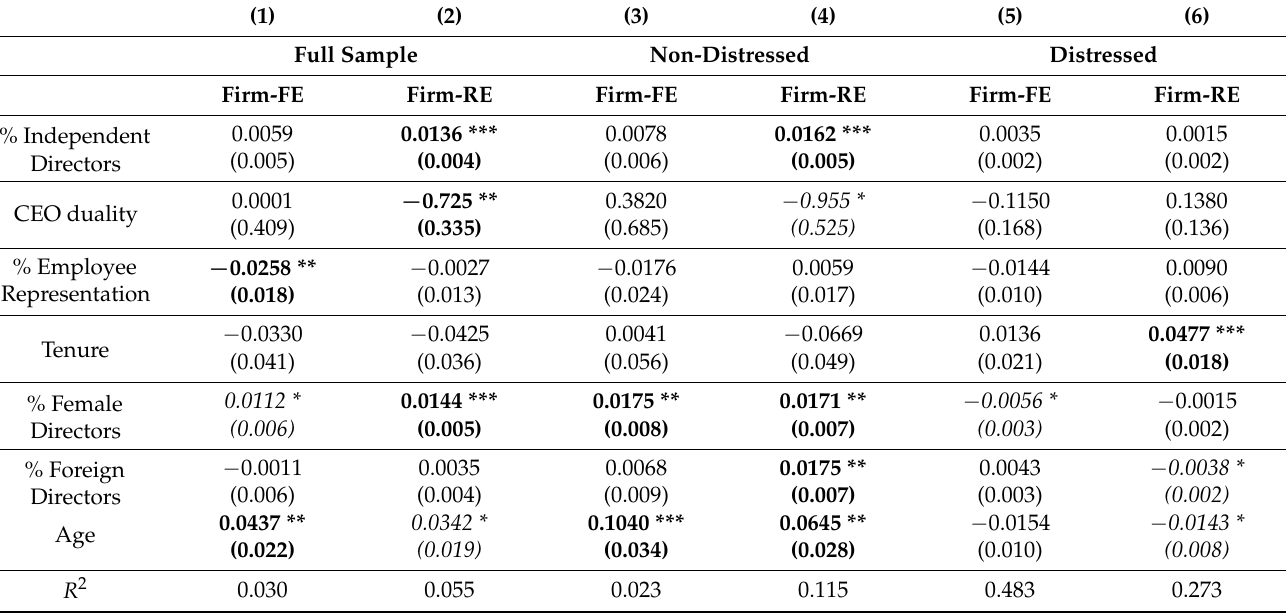
Table 5. Board Governance and Risk of Insolvency with Alternative Specifications.